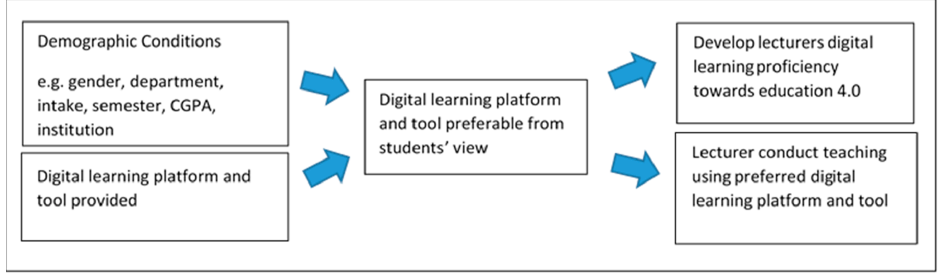
Figure 1. Proposed theoretical framework.